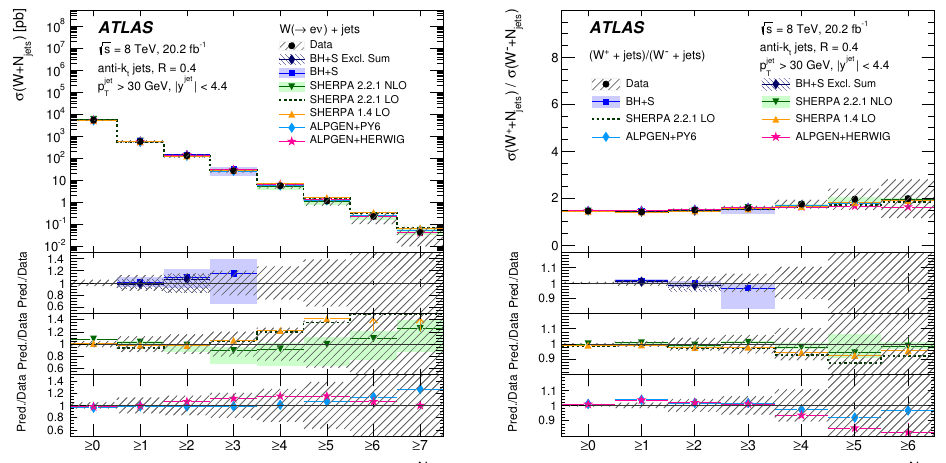
Figure 2 . Cross section for the production of W bosons (left) and the W + =W (cid:0) ratio (right) for di(cid:11)erent inclusive jet multiplicities. For the data, the statistical uncertainties are indicated as vertical bars, and the combined statistical and systematic uncertainties are shown by the hatched bands. The uppermost panel in each plot shows the di(cid:11)erential cross sections, while the lower panels show the ratios of the predictions to the data. The theoretical uncertainties on the predictions are described in the text. The arrows on the lower panels indicate points that are outside the displayed range.